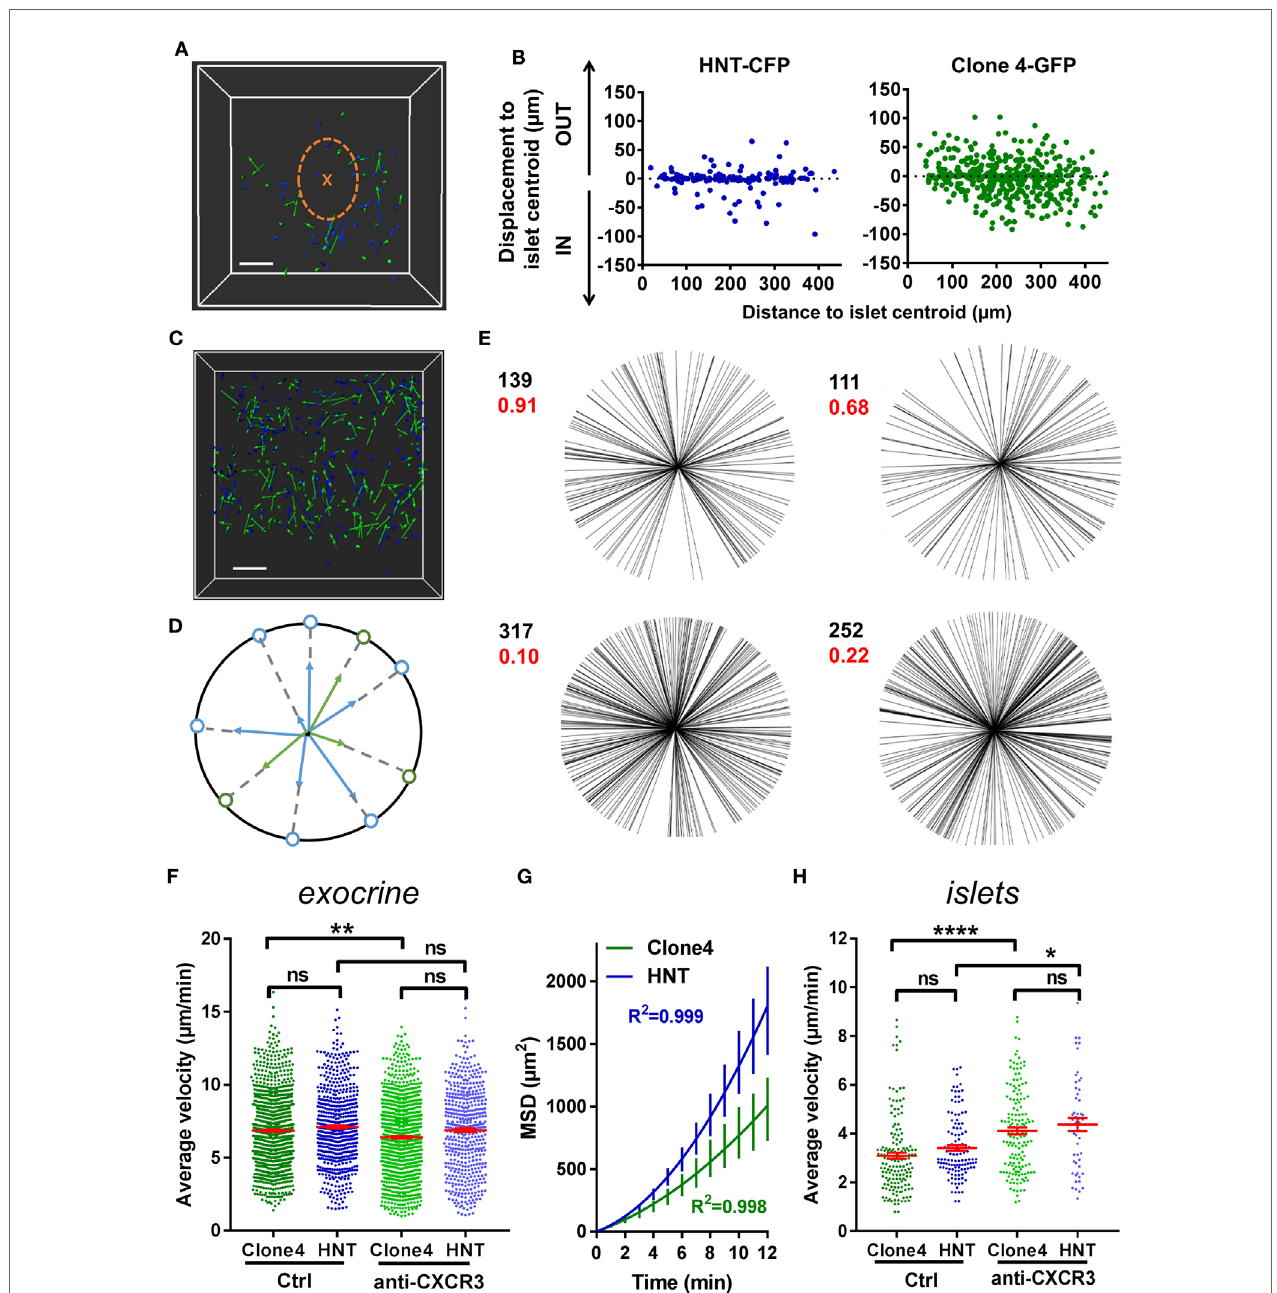
FigUre 2 | T cells collective migration is not biased toward islets and is mostly independent of CXCR3 signaling. Irradiated InsHA-mCherry mice adoptively transferred with Clone 4-GFP CD8 + and HNT-CFP CD4 + T cells were subjected to intra-vital microscopy on day 8. (a) XY projections of track displacement vectors of T cells in movie in Figure 1a (see Video S1 in Supplementary Material). Scale: 100 µm. Blue and green tracks correspond to HNT-CFP and Clone 4-GFP T cells, respectively. Islet is circled, and a cross marks islet centroid. (B) Clone 4-GFP and HNT-CFP displacement during movies toward (IN) or away (OUT) from islets, as a function of distance from islet centroid at the start of movies ( n = 4 mice; 1–2 movies/mouse). (c) XY projections of T cell track displacement vectors in exocrine tissue (see Video S2 in Supplementary Material) (scale: 100- and 200-µm Z -projection; green: GFP, blue: CFP). Movie duration: 10 min. (D) To analyze orientations of T cell directions, displacement vectors were projected on the XY plane and set to a common origin. The orientation of each vector was projected on a circle. (e) Statistical analysis of T cell track orientations in four different movies (without islet) (numbers in black correspond to the number of tracks). None of the analyzed distributions were significantly different from a uniform distribution (Hodjes–Ajne test for circular uniformity, P -values in red). (F) The average velocities of CD4 + and CD8 + T cells in the exocrine tissue ( n = 4–6 mice/condition; 2–3 movies/mouse, one-way ANOVA). Dots correspond to individual T cells. CXCR3: anti-CXCR3 mAb-treated mice. (g) MSD of T cells as a function of time in the exocrine tissue, best fitted with a Lévy walk super-diffusive model of migration. Bars correspond to SEM ( n = 4 mice per condition; 1–2 movies/mouse). (h) The average velocities of CD4 + and CD8 + T cells in islets ( n = 5–6 mice/condition; 1 movie/mouse, one-way ANOVA). Dots correspond to individual T cells. Bars correspond to SEM.